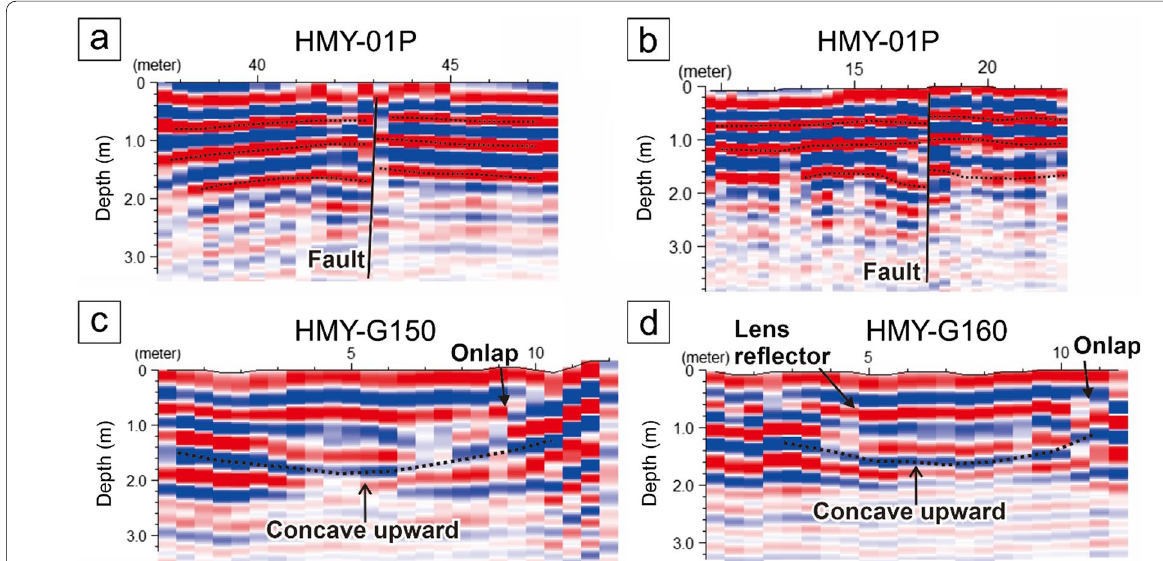
Fig. 4 Typical faults ( a , b ) and paleochannels ( c , d ) observed in this study